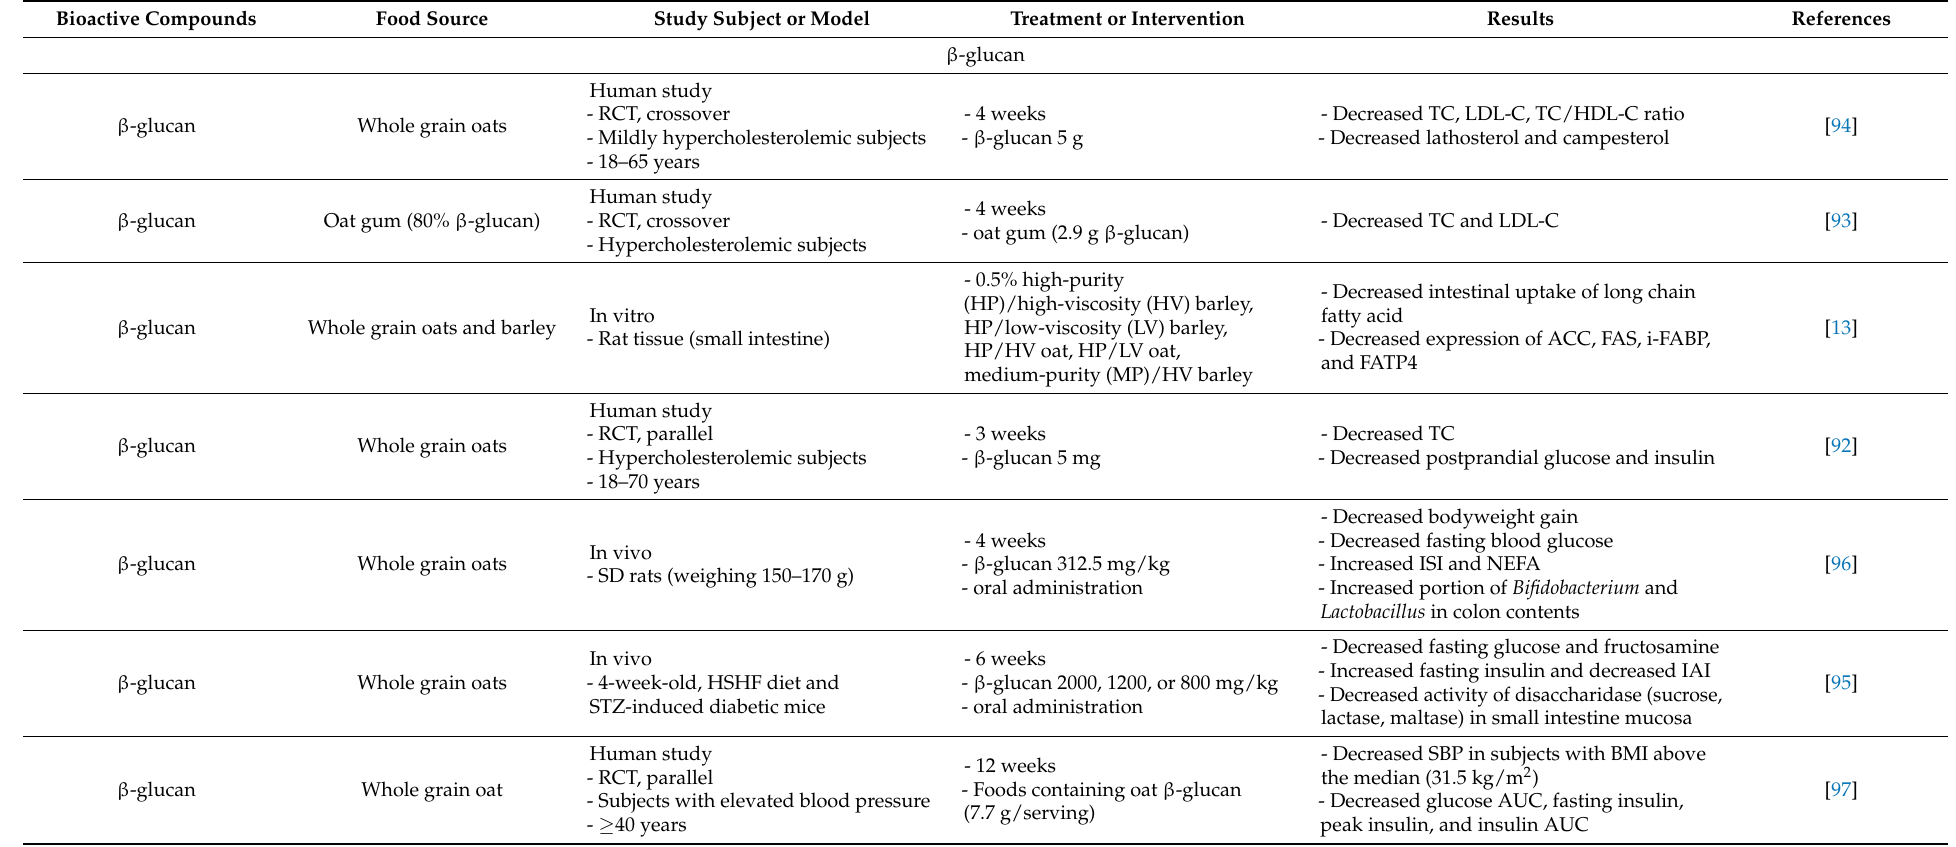
Table 4. Effects of fiber on cardiovascular and metabolic